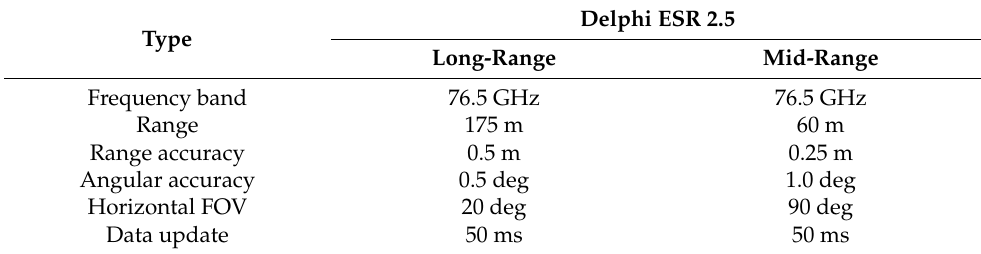
Table 1. Automotive radar system specifications.